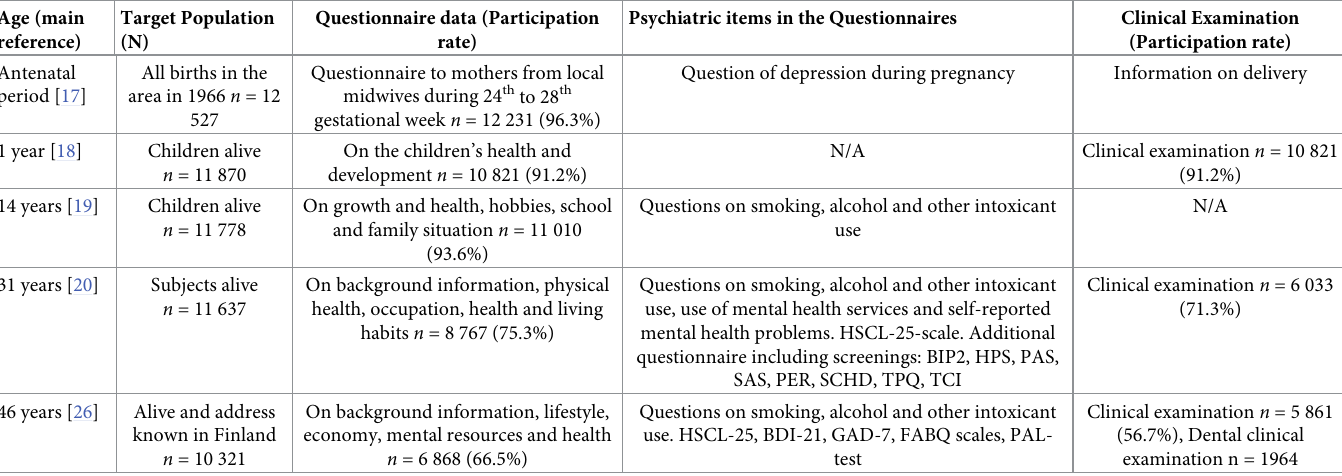
Table 1. Follow-ups of the Northern Finland Birth Cohort 1966 (NFBC